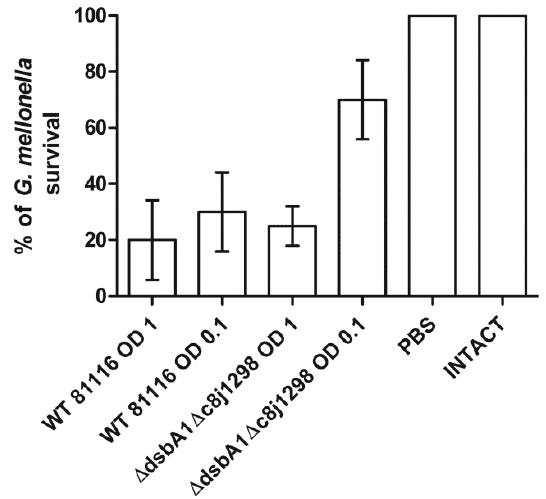
Figure 13. Survival of Galleria mellonella infected with C. jejuni strains. Virulence assay was performed with C. jejuni 81116 wild-type (WT) and double-mutated ∆ cjdsbA1 ∆ c8j_1298 strain. Larvae were injected 10 5 (OD 590 0.1) or 10 6 (OD 590 1) C. jejuni , then survival was assessed after 24 h. Larvae injected with PBS or uninjected (INTACT) were used as controls. No statistically significant differences were observed between compared groups.